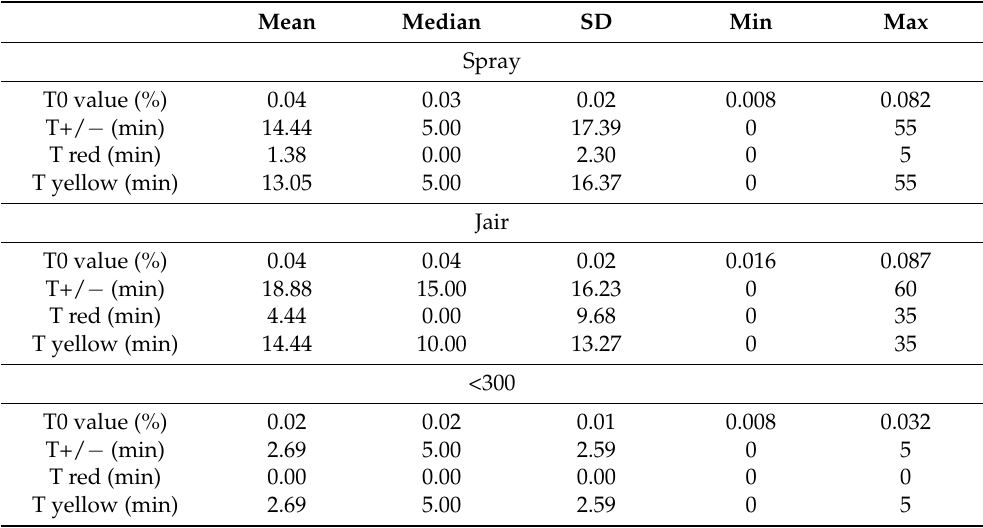
Table 1. Descriptive results of the statistical analysis of the type of ethanol administration, volume of ethanol used, and time of exposure, expressed as mean, median, standard deviation (SD), and minimum and maximum